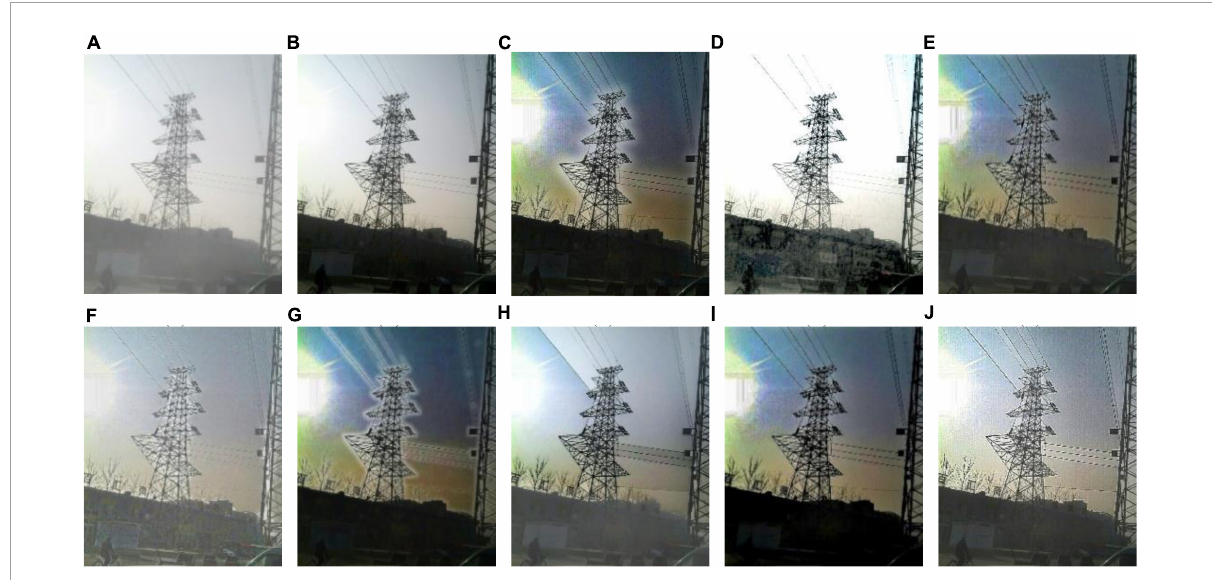
FIGURE11 Experimental results of different methods for Figure 4 : (A) input image; (B) ground truth; (C) dark channel prior; (D) Fattal et al.; (E) Meng et al.; (F) Tarel et al.; (G) Ehsan et al.; (H) Berman et al.; (I) Raikwar et al.; (J) proposed.